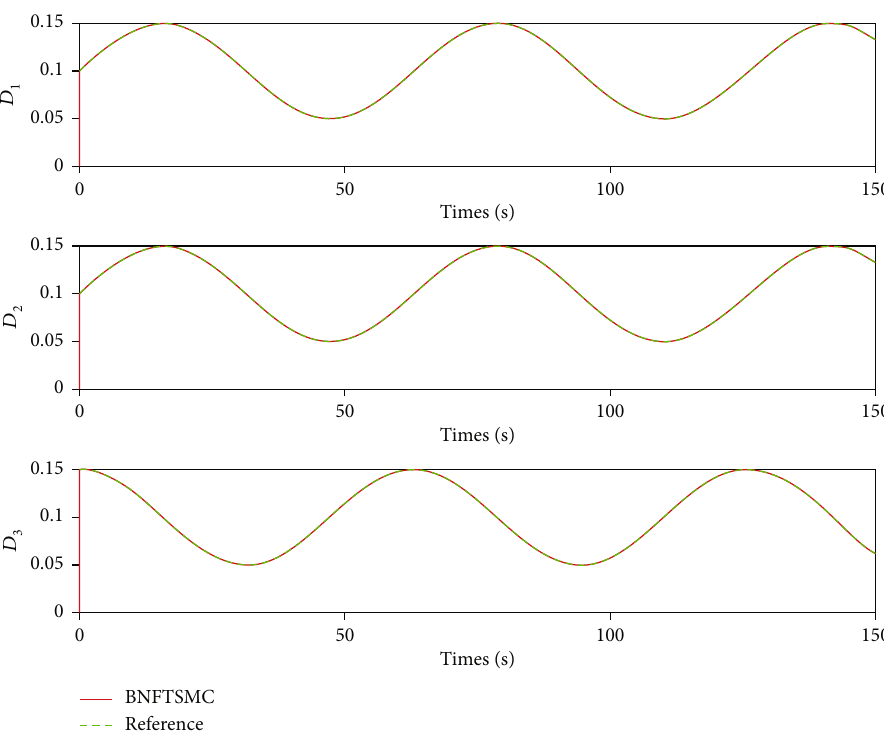
Figure 16: Estimation of the disturbances in position